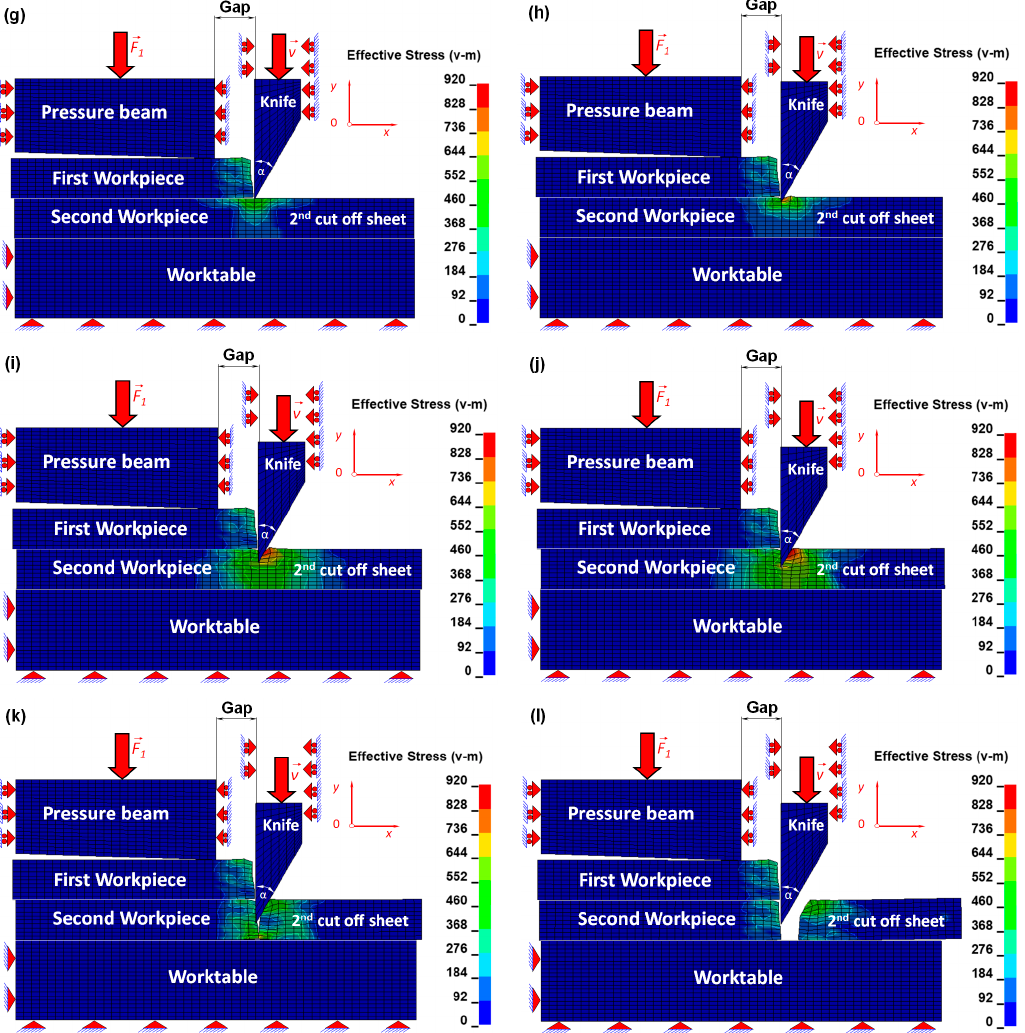
Figure 5. Huber–Mises stresses in the second sheet being cut for the following time instances: ( g ) t = 7.5 s, ( h ) t = 8 s, ( i ) t = 9 s, ( j ) t = 9.5 s, ( k ) t = 10.1 s, ( l ) t = 10.11 s (continuation of Figure 4).